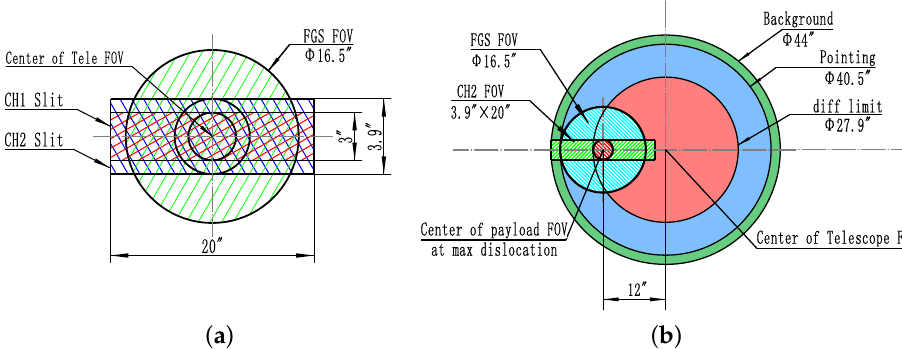
Figure 4. ( a ) FOV of pointing system (green) and spectrometers (red CH1, blue CH2) when ideally aligned. ( b ) Layout of final system FOV.